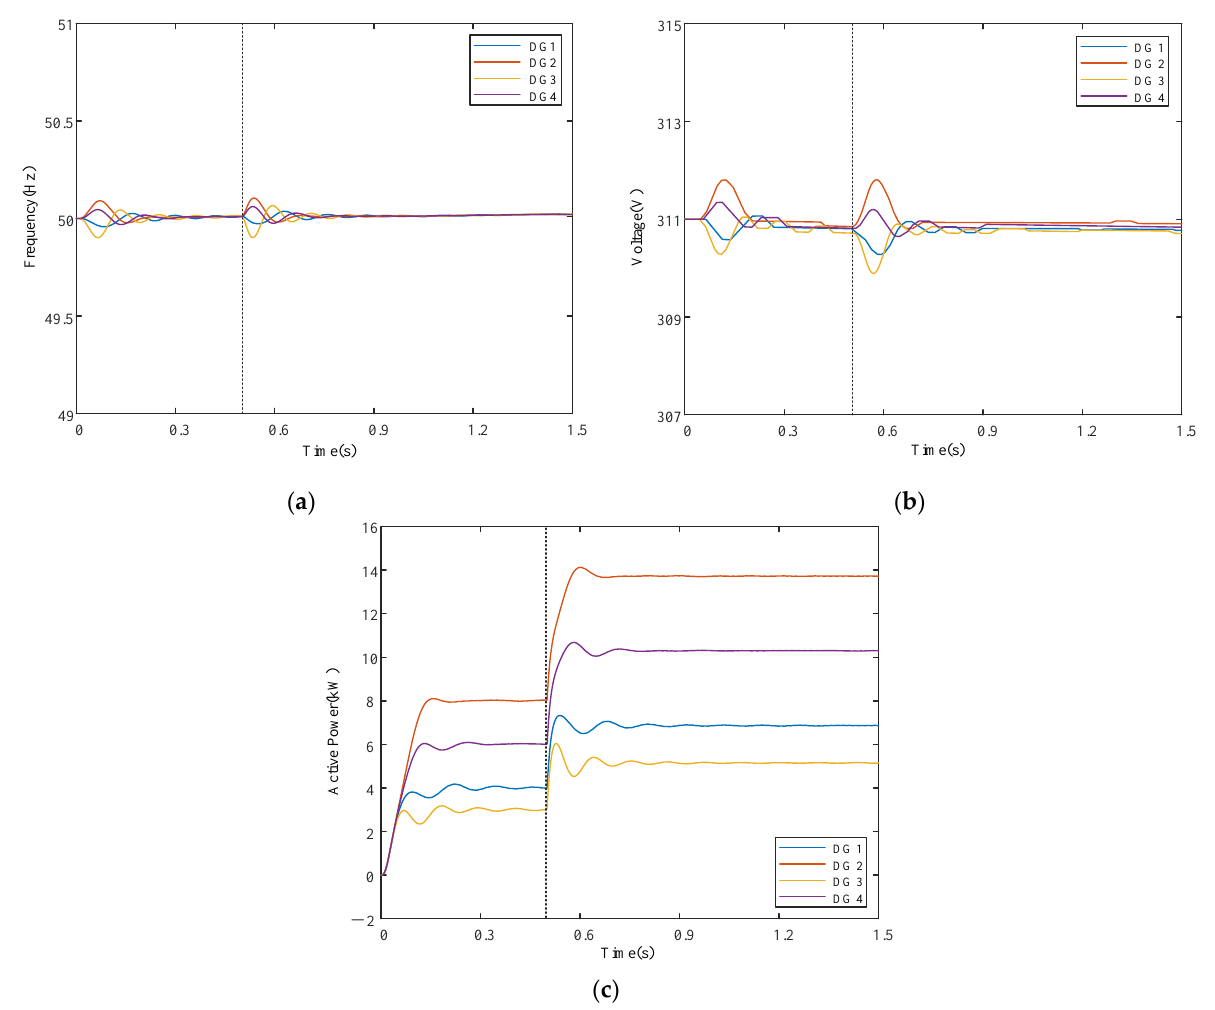
Figure 5. ( a ) Frequency output waveform; ( b ) voltage output waveform; ( c ) active power output waveform.